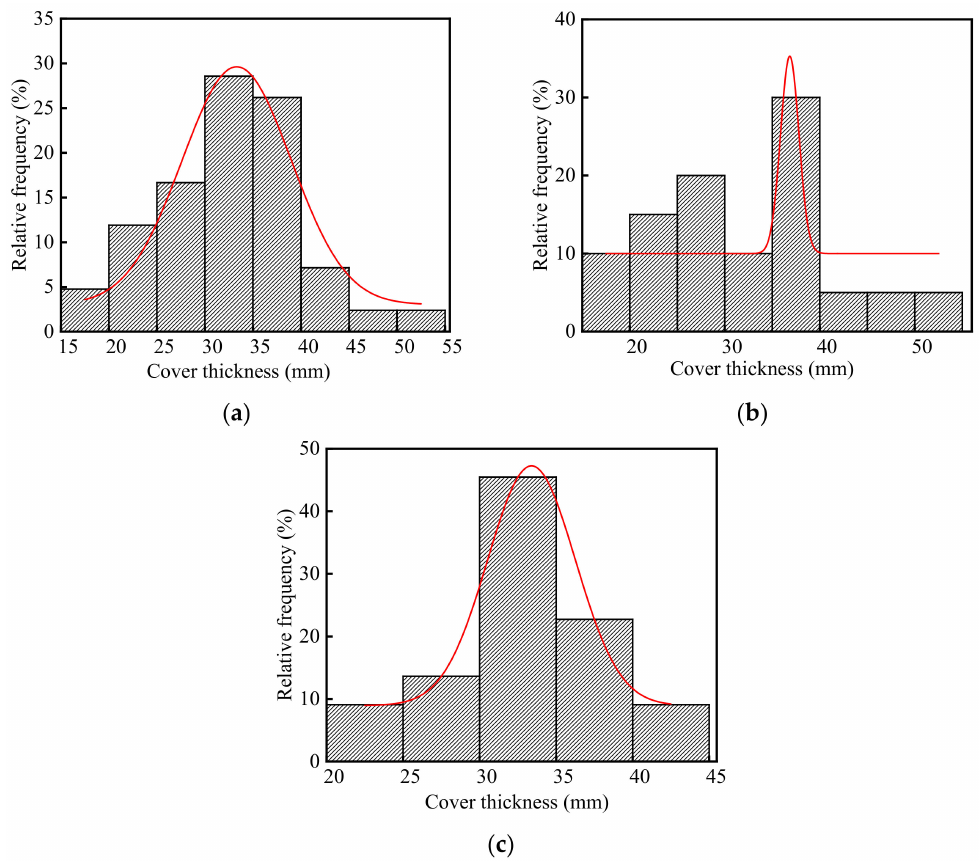
Figure 6. Frequency distribution histograms of concrete cover thickness in the steelworks: ( a ) Both in the ingot casting bay and billet bay; ( b ) Ingot casting bay; ( c ) Billet